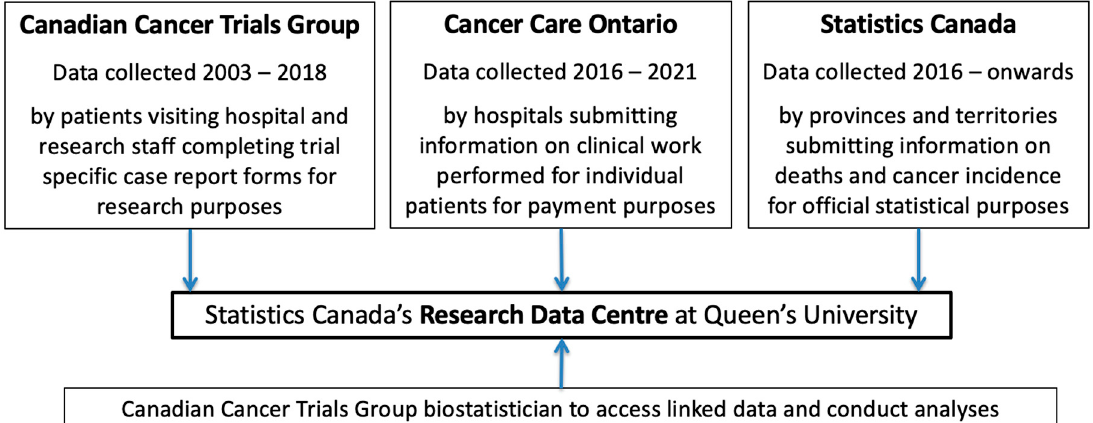
Figure 1. LIFE study design.